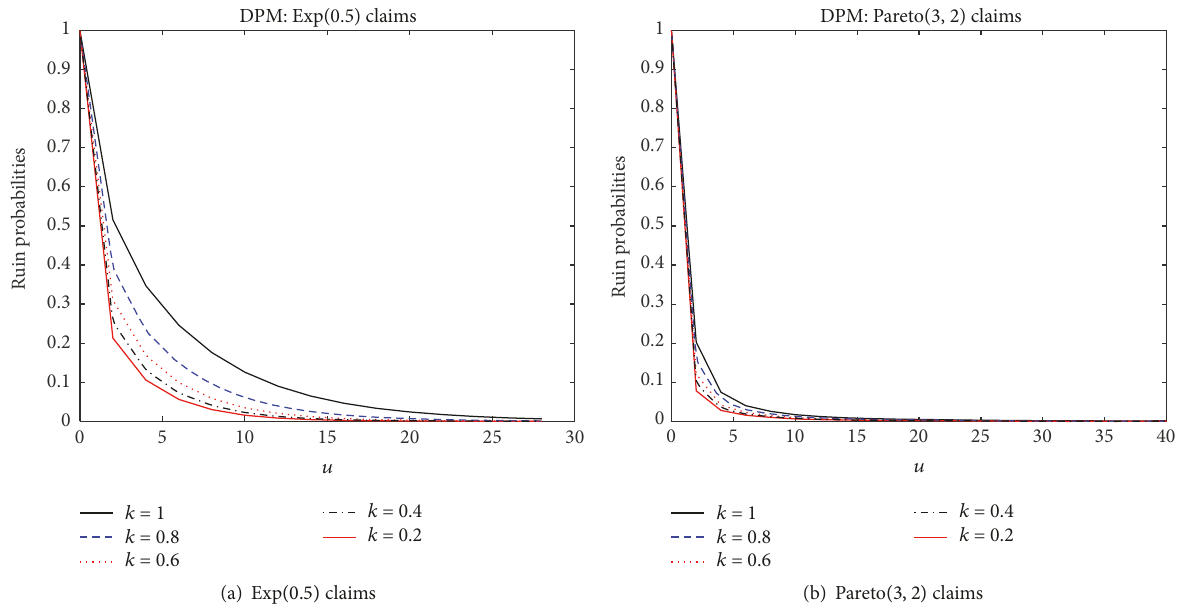
Figure 2: Ultimate ruin probabilities at different proportional retention levels in the diffusion-perturbed model: 𝜆 = 2 , 𝑐 = 6 , 𝜎 = 0.02 .